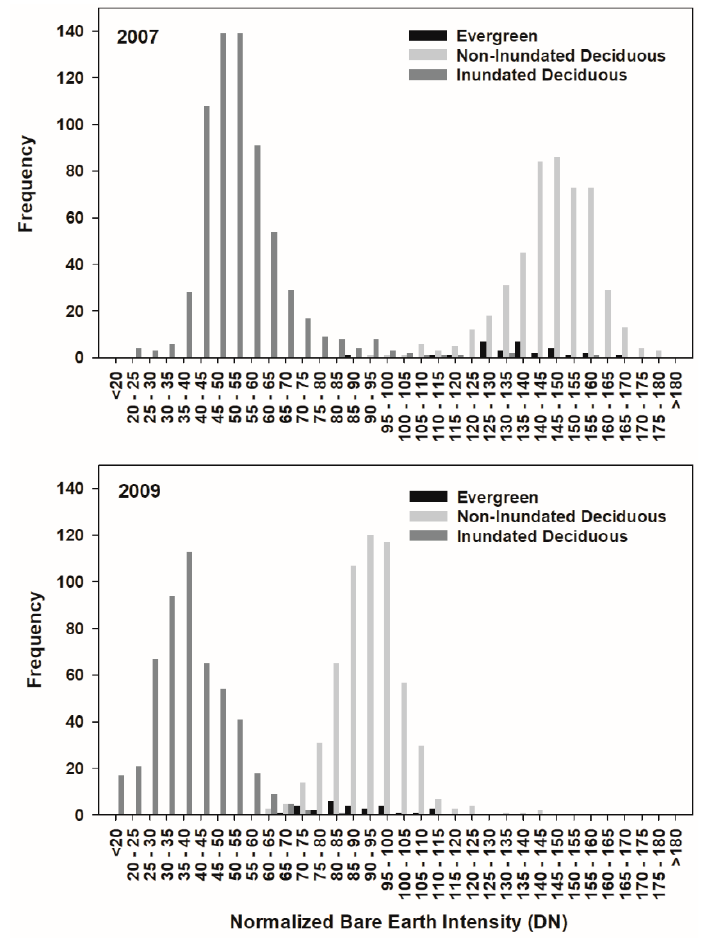
Figure 6. Frequency distributions plotted at 5 digital number (DN) intervals depicting 27 March, 2007 (top) and 24 March, 2009 (bottom) normalized bare earth return values extracted for in situ data points, including evergreen, inundated deciduous, and non-inundated deciduous points. Note that all evergreen points were non-inundated.